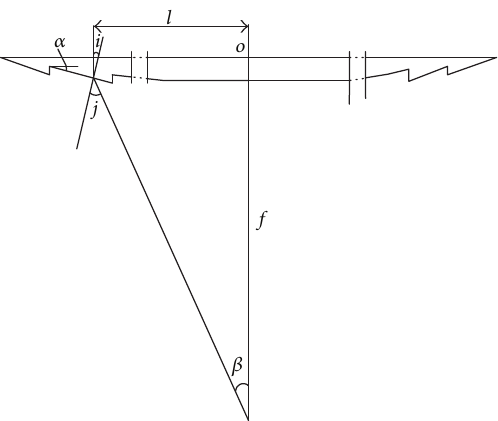
Figure 1: Schematic diagram of a flat Fresnel solar